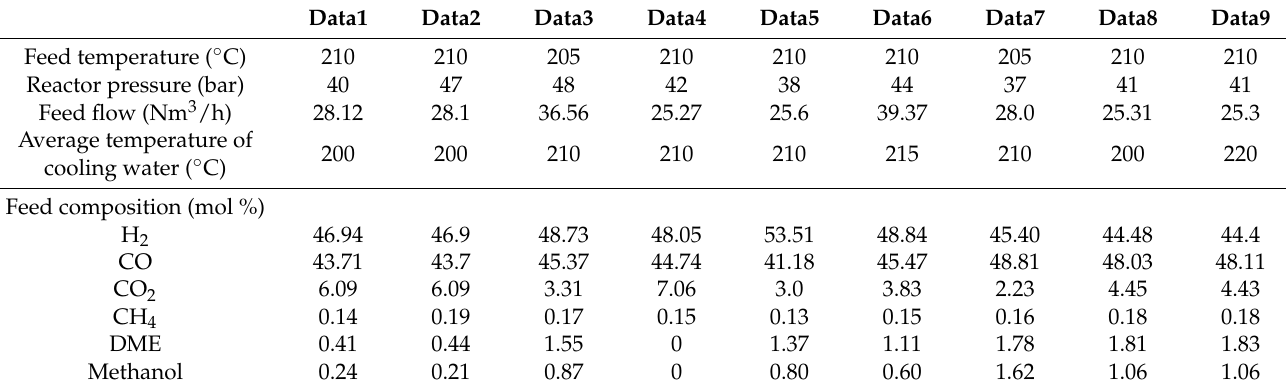
Table 2. The data set of pilot-plant operation